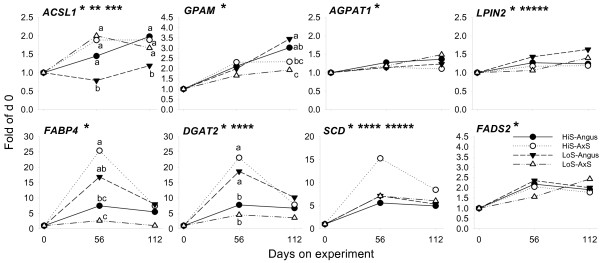
mRNA expression patterns of genes associated with intracellular activation of fatty acids to acyl-CoA (ACSL1), glycerol-3-phosphate acylation (GPAM), acylglycerol-phosphate acylation (AGPAT1), diacylglycerol formation (LPIN2), intracellular fatty acid transport (FABP4), acylation of diacylglycerol and formation of TAG (DGAT2), and desaturation (SCD, FADS2) in Angus or A × S steers (n = 6/type) fed a high-starch (HiS, n = 3/type) or low-starch (LoS, n = 3/type) diet. Fold-change expression during the growing phase is expressed relative to day 0. Pooled SEM: ACSL1, 0.2; GPAM, 0.3; AGPAT1, 0.1; LPIN2, 0.1; FABP4, 4.2; DGAT2, 3.8; SCD, 1.8; FADS2, 0.2. Asterisks denote (P < 0.05): *Time effect; **Diet effect; ***Steer type effect; ****Tendency (P = 0.08–0.11) for diet × steer type × day interaction; *****Tendency (P = 0.11–0.13) for steer type effect. ACSL1 and GPAM had (P < 0.05) diet × steer type × day interactions. FABP4 and DGAT2 had (P < 0.05) diet × steer type interactions. Superscripts denote differences (P < 0.05) among treatments at specific time points.